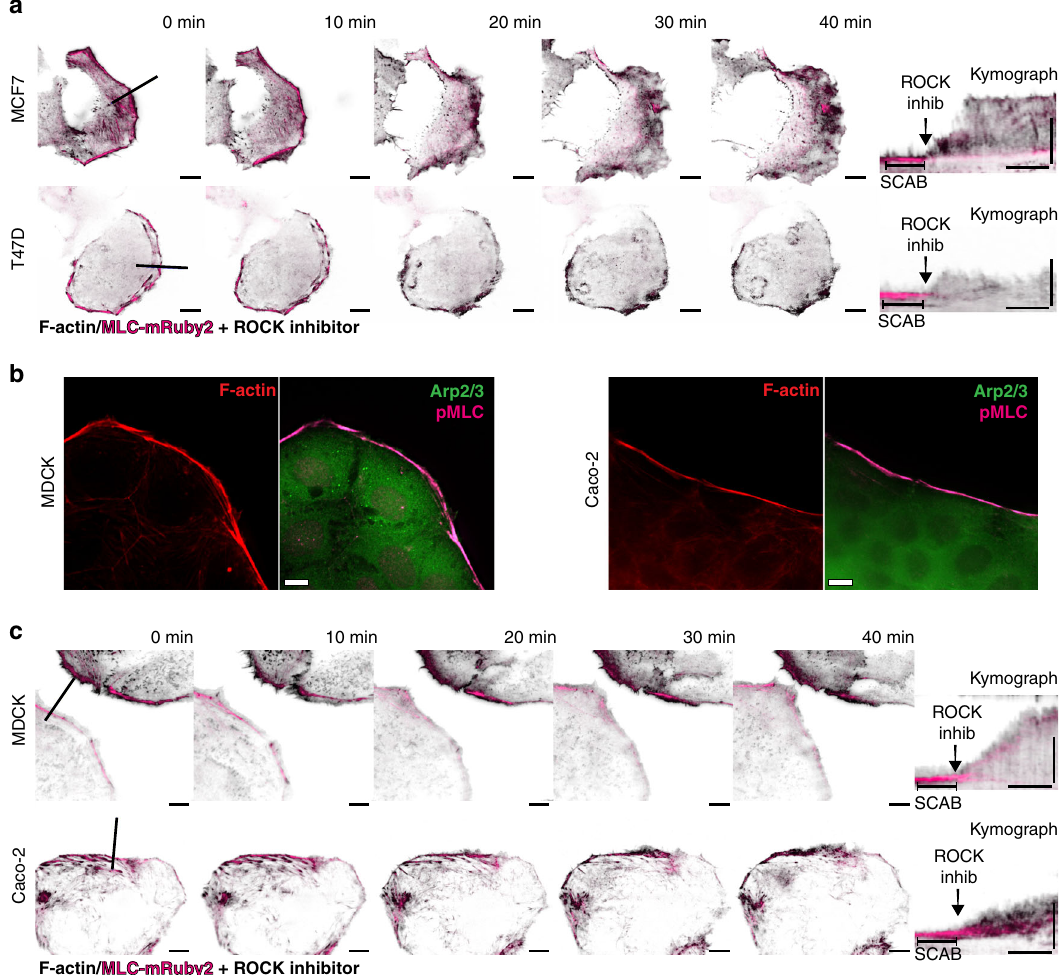
Fig. 3 SCABs suppress leading edge motility in a myosin contractility-dependent manner. a Leading edge kymography in MCF7 cells (top row) and T47D cells (bottom row) expressing iRFP-Lifeact (black) and MLC-mRuby2 (magenta) before and after dissolving SCABs using 25 µ M ROCK inhibitor. Left panels are images from TIRF microscopy time-lapse series before and after the addition of ROCK inhibitor (Supplementary Movie 5). Scale bar is 10 µ m. Line shows the leading edge position at which kymographs were registered. Right panel shows MLC kymograph (denoting SCABs) superimposed over Lifeact kymograph (demarcating the leading edge). Vertical scale bar is 10 µ m and horizontal scale bar is 10 min. b Immuno fl uorescence of SCAB in MDCK epithelial cells and Caco-2 human intestinal epithelial cells. Representative images for F-actin, pMLC, and Arp2/3. Scale bar is 10 µ m. c Leading edge kymography in MDCK cells (top row) and Caco-2 (bottom row) cells expressing iRFP-Lifeact (black) and MLC-mRuby2 (magenta) before and after dissolving SCABs using 25 µ M ROCK inhibitor. Scale bar is 10 µ m. Line shows the leading edge location at which the kymograph was registered. Right panel shows MLC kymograph (denoting SCABs) superimposed over Lifeact kymograph (demarcating the leading edge). Vertical scale bar is 10 µ m and